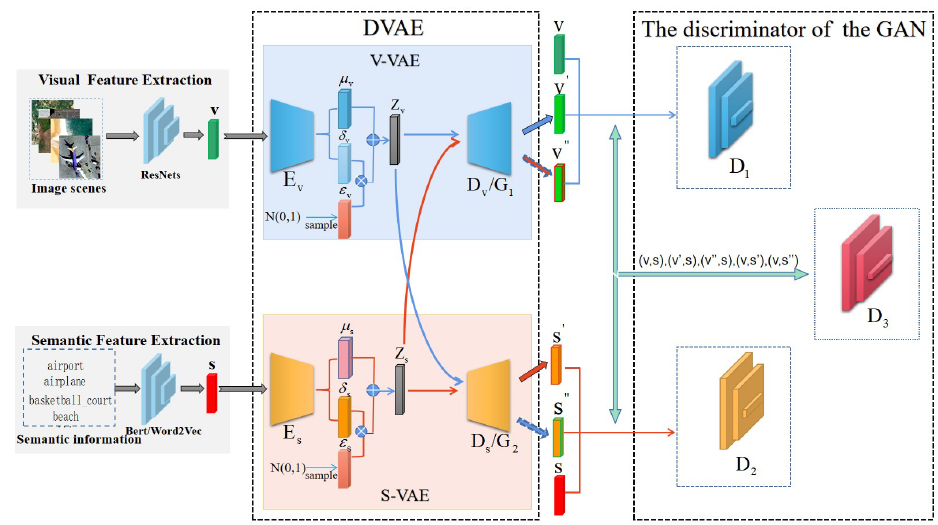
Figure 2. The model architecture of the proposed